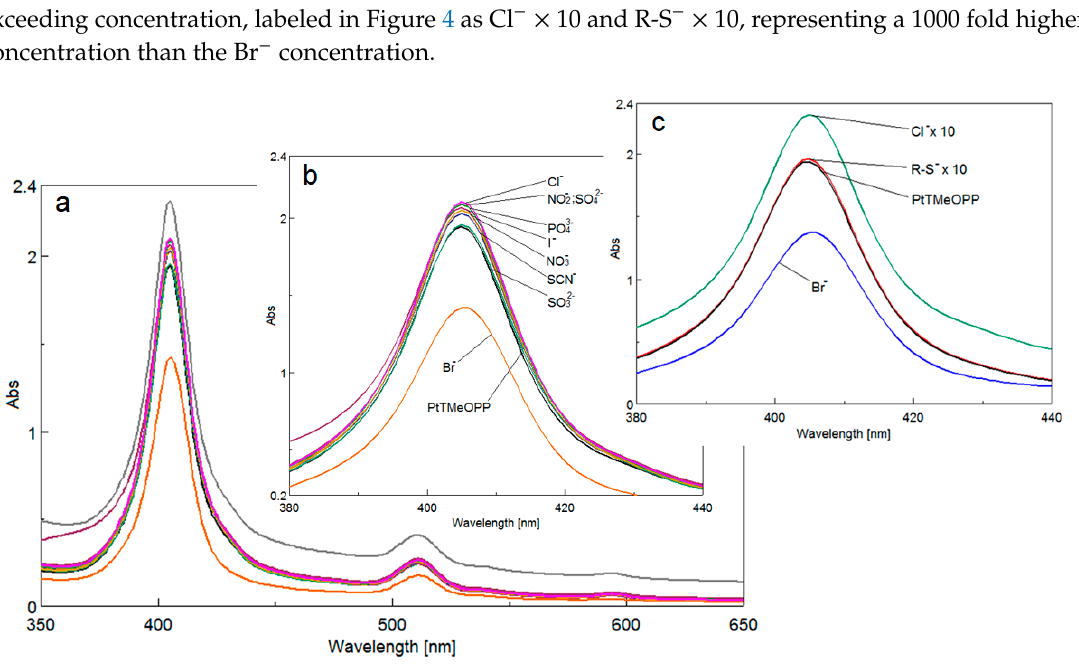
Figure 4. Overlapped UV-Vis spectra showing the effect of potential interfering anions on PtTMeOPP solution. ( a ) Detail of the Soret bands with 100-fold ( b ) and 1000-fold ( c ) higher concentration of interferences than the Br ‾ concentration.